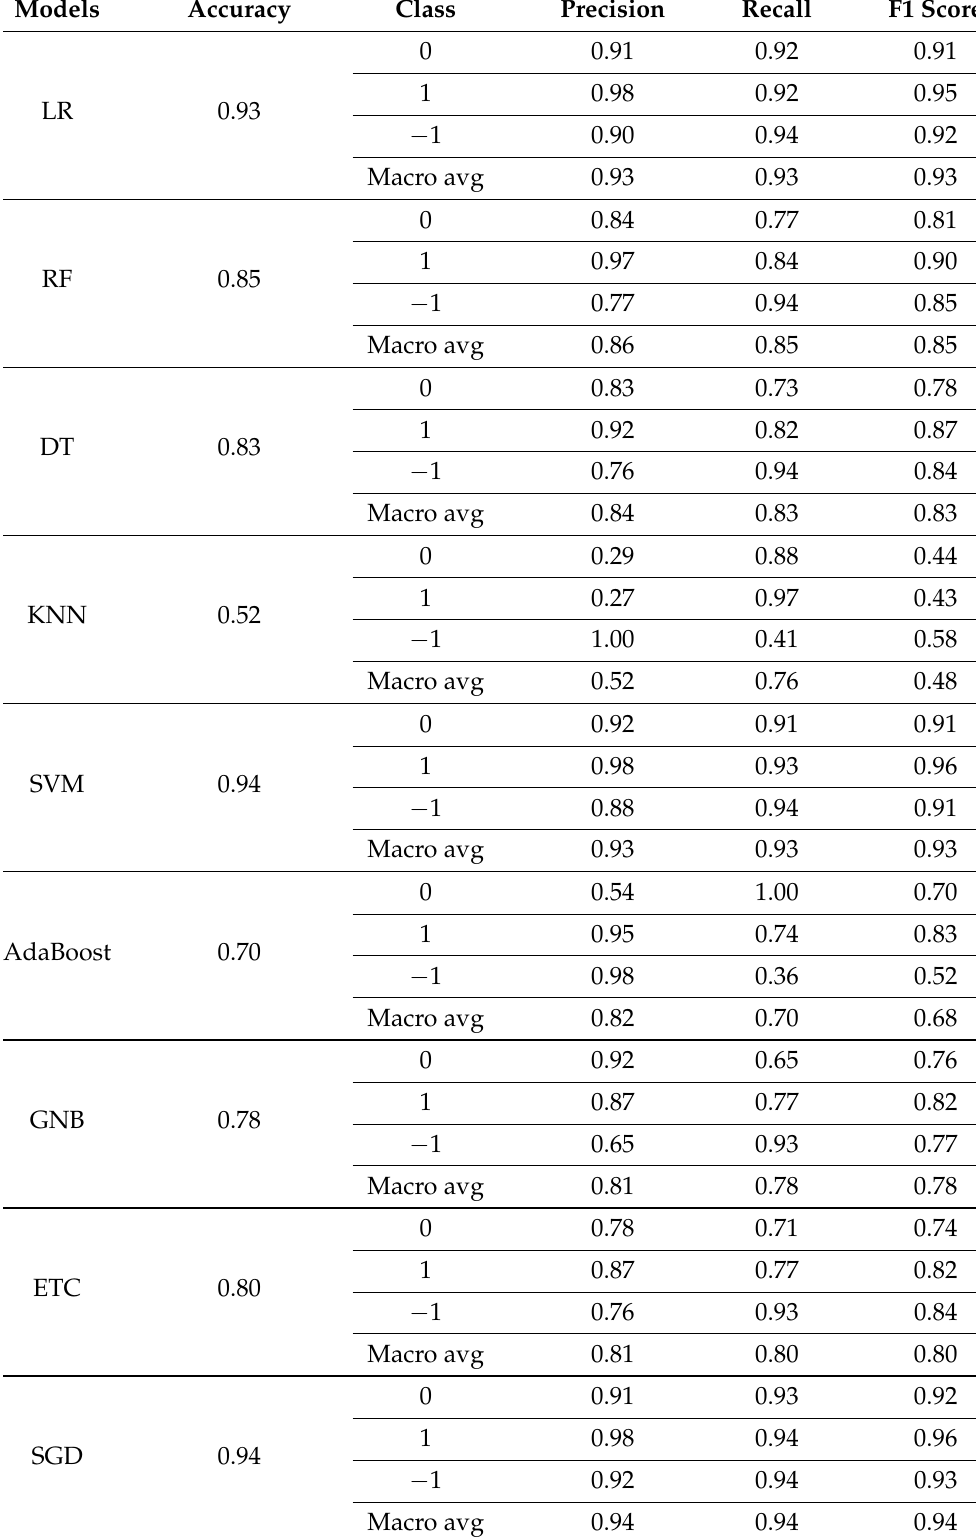
Table 12. Results using TF-IDF features on the original